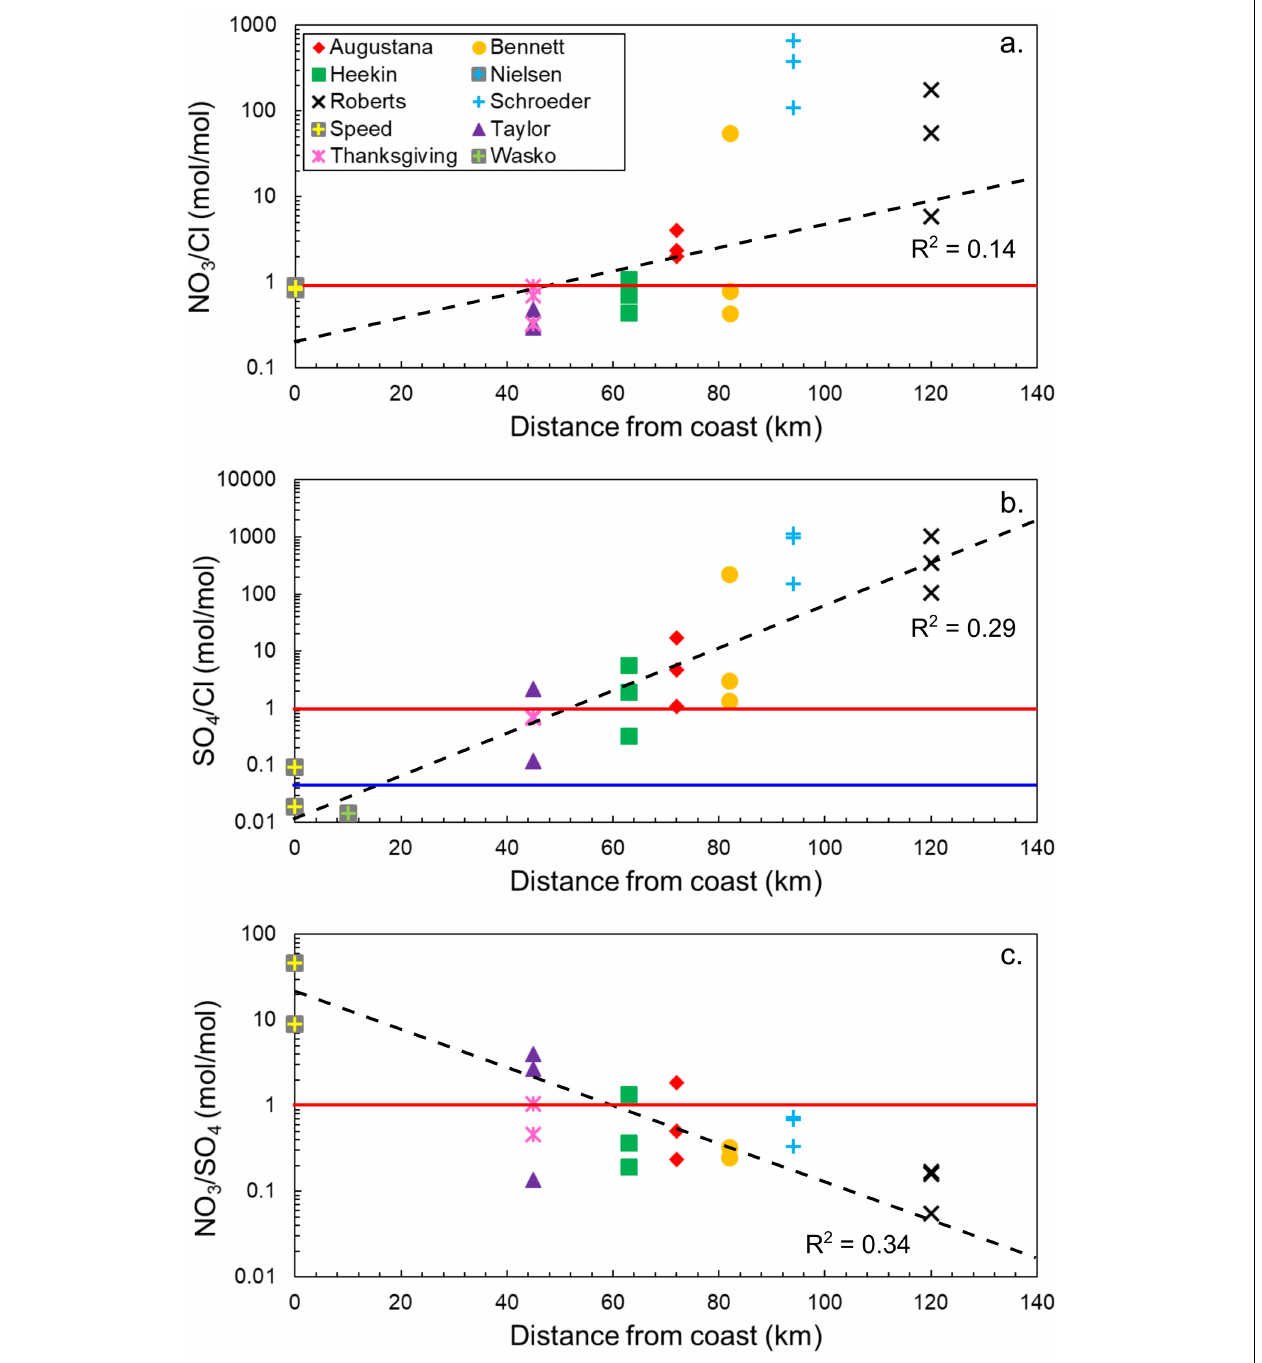
FIGURE 2 | Molar ratios of major anion species typically associated with salts in high latitude, polar desert soils [ (a) NO 3 - /Cl - , (b) SO 42 - /Cl - , and (c) NO 3 - /SO 42 - ] compared to distance from the coast of the Ross Ice Shelf. The black dotted lines represent general trends in the data, while the red solid line represents equal molar proportions of the anions and the blue line represents the SO 4 :Cl molar ratio in seawater.